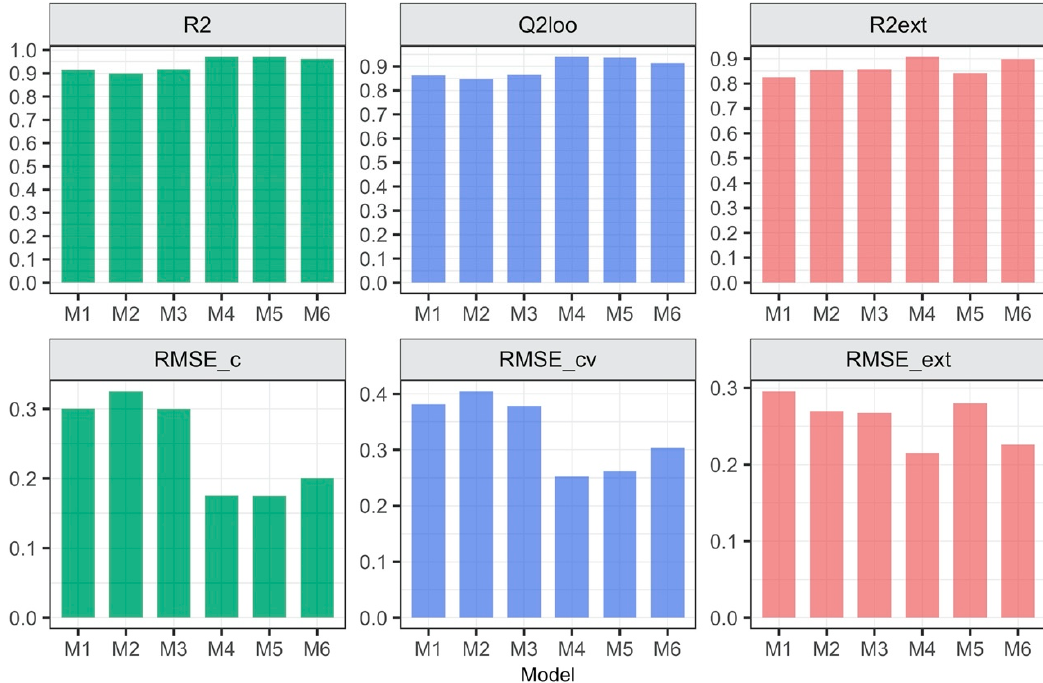
Figure 2. Quality measurements of the developed QSAR models.